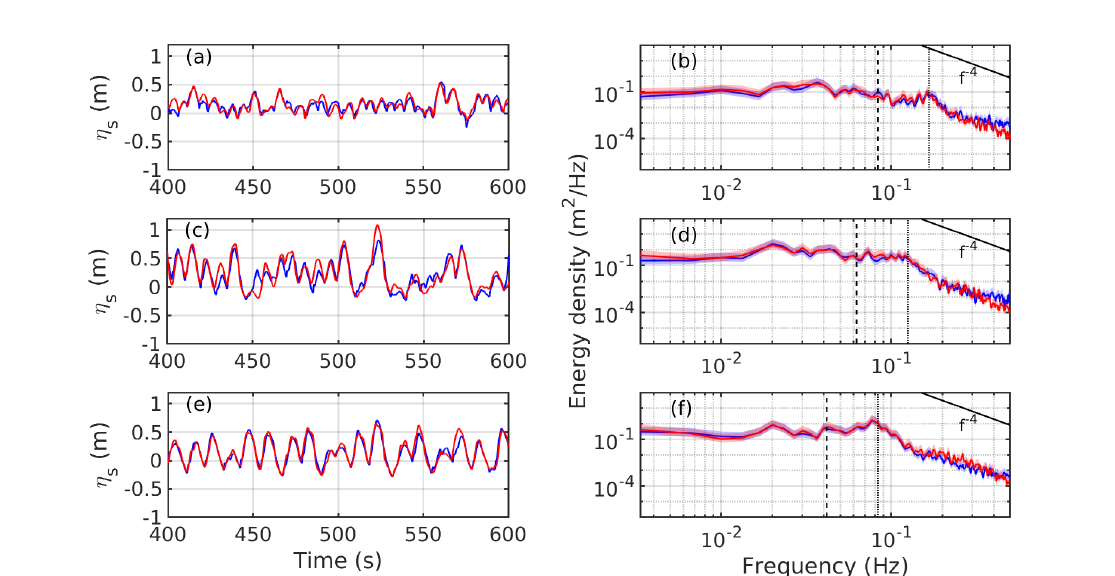
Figure 8. Comparisons between the observed (red) and simulated (blue) continuous shoreline elevation η s and swash spectra for cases DR0 ( a , b ), SBE2 ( c , d ), and SBA1 ( e , f ). Blacked dashed line: IG cutoff frequency ( f p /2). Black dotted line: peak frequency f p . Shaded areas define the 95% confidence intervals.